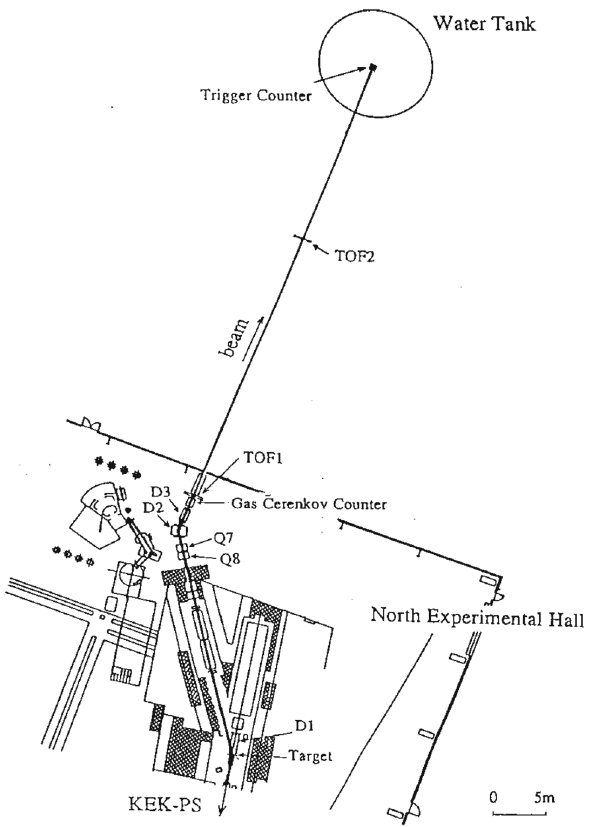
Fig. 2 KEK PS K6 beamline and prototype water Cherenkov